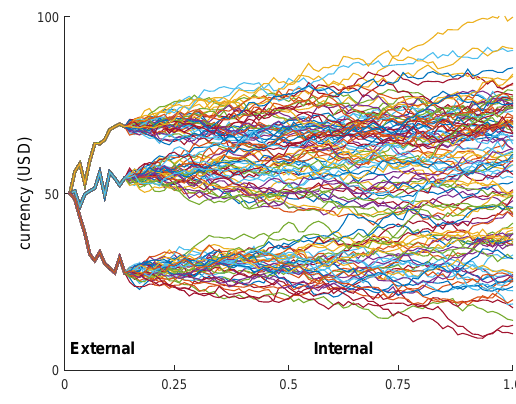
Figure 1. Illustration of nested Monte Carlo (MC) simulations: External paths (until calculation date) and Internal paths (until derivative